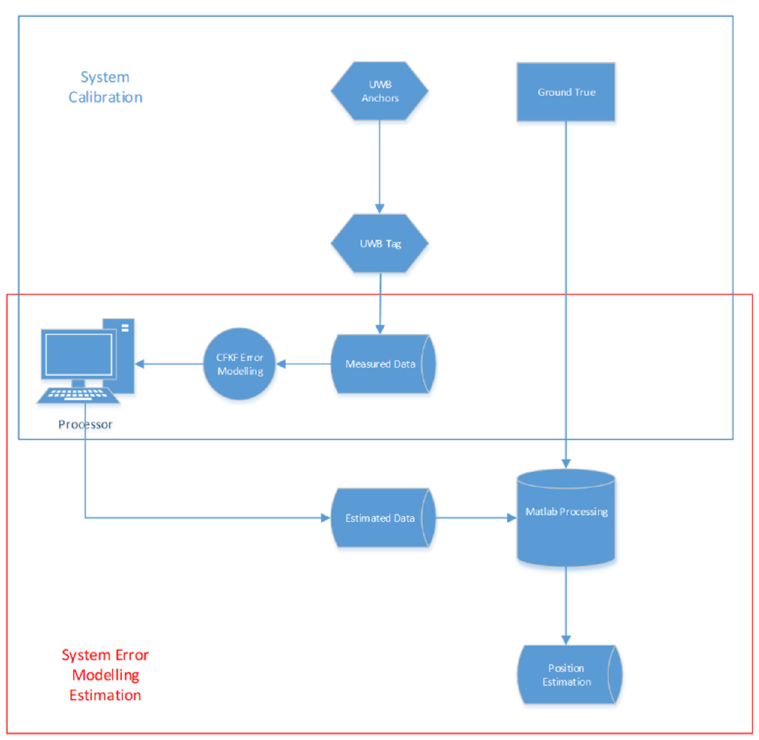
Figure 3. System calibration and error modelling estimation for UWB localization.